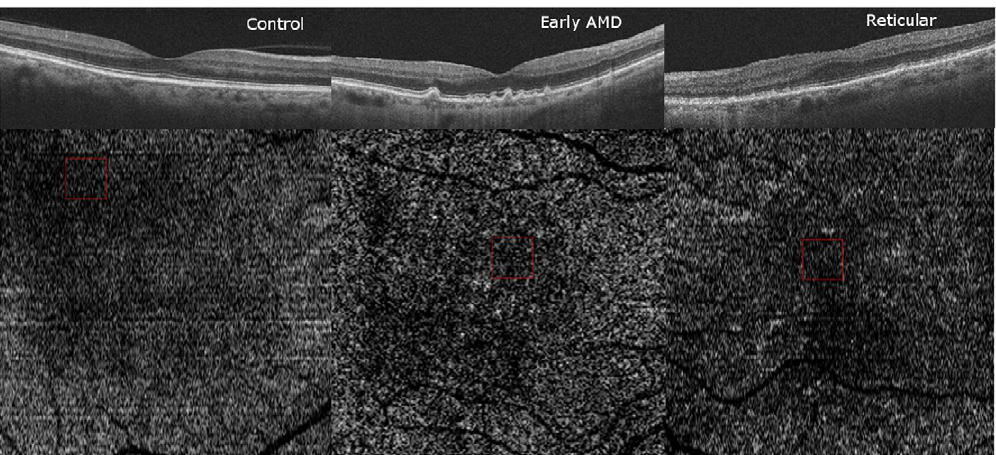
Figure 9. Altered Curvature of the Retinal Pigment Epithelium (RPE). Analyzing 6 6 6 mm C- scans obtained in the most superficial choroidal layers for all groups were affected by the variance in curvature of the RPE, especially in eyes with thin choroid (middle panel). Examples of high density (HD) raster scans and 6 6 6 mm C-scans from the control (left), early age-related macular degeneration (AMD, center) and reticular (right) groups are shown. In order to overcome these differences, selected 1 6 1 mm representative areas from the full C-scans were used for further analysis (red squares, bottom panel).